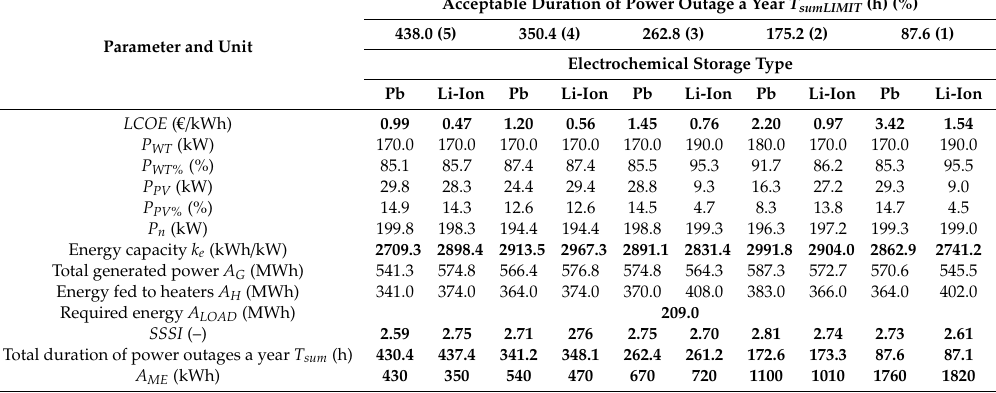
Table 6. Results of PV-wind hybrid power supply system structure optimization (lead–acid and lithium-ion battery) for a 50 kW peak power of an industrial load with the power generation system rated power P n limited to 200 kW (for: I ESPb = I ESLi-Ion = 533.3 € / kWh, M ES = 22.2 € / kWh, I ESLi-Ion = 426.7 € / kWh, M ES = 22.2 € / kW, I PV = 1359 € / kW, I TW = 1571 € / kW, M PV = 25.3 € / kW, M WT = 11.1 € / kW, NM = 25 years, r = 5%).